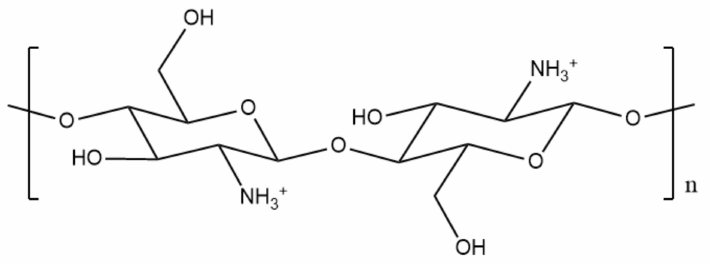
Figure 3. Chemical structure of